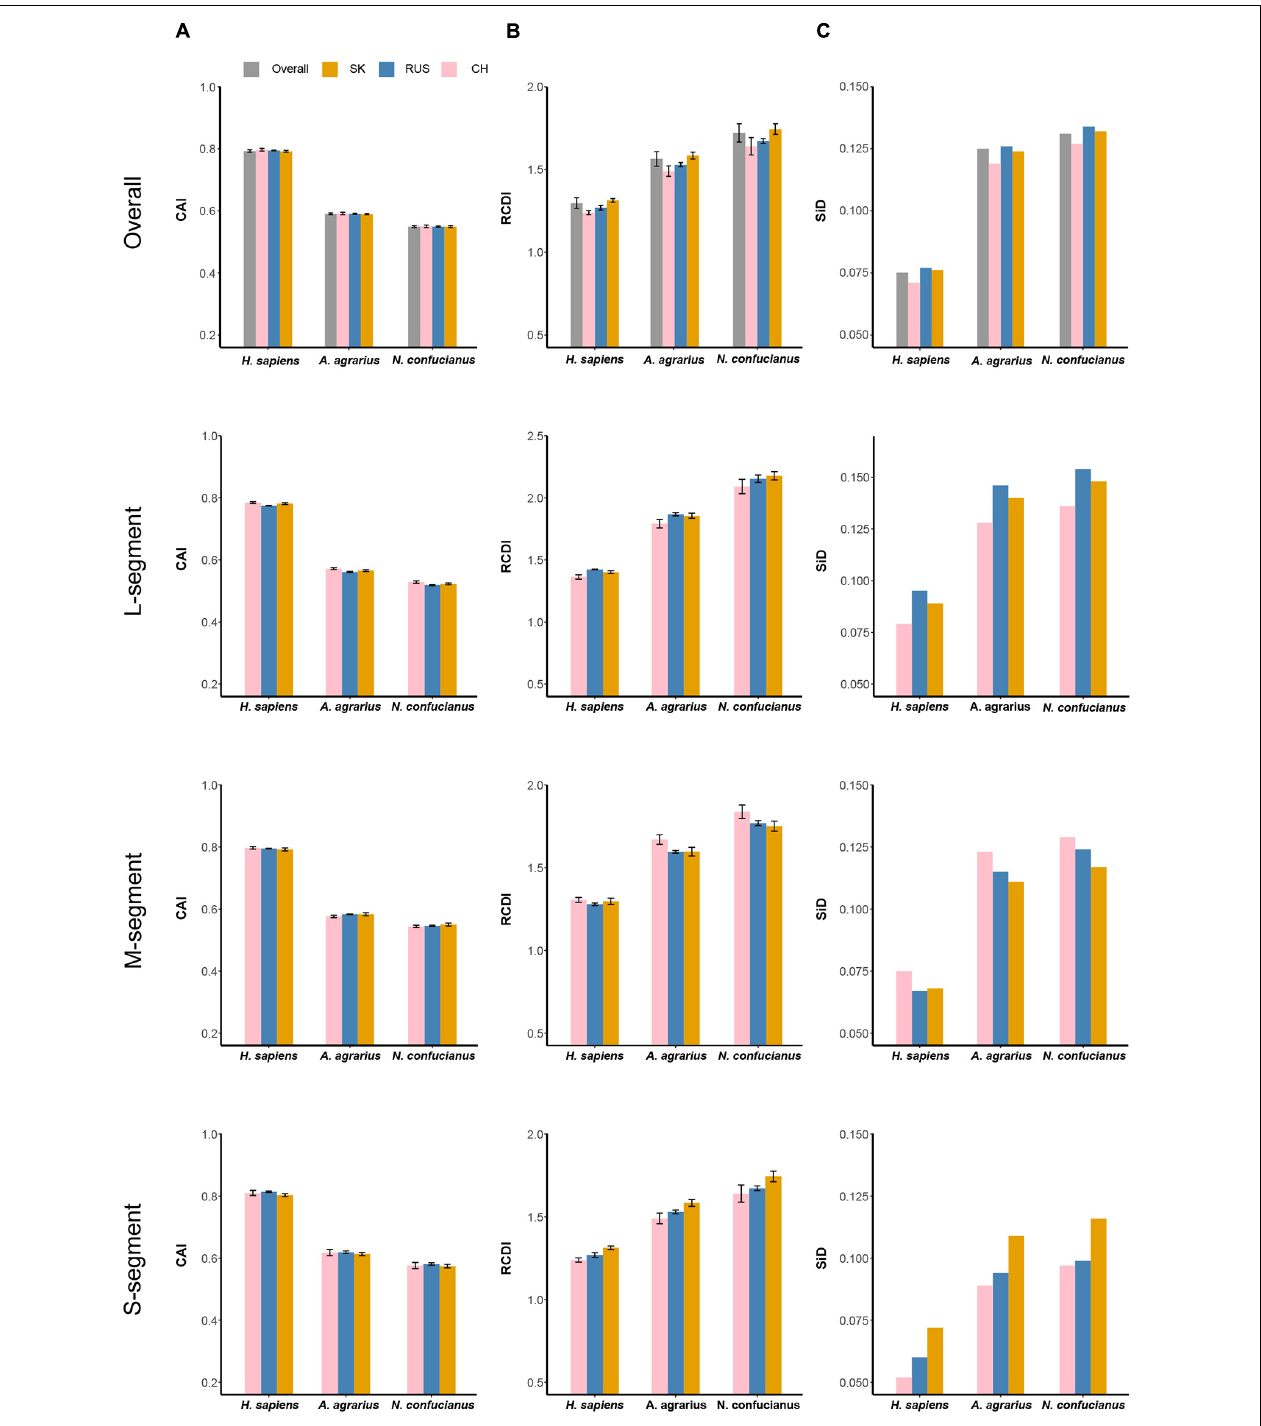
FIGURE 8 | Codon usage adaptation indices of HTNV to its host and natural reservoirs. (A) Codon adaptation index (CAI), (B) relative codon deoptimization index (RCDI), and (C) similarity index (SiD). Standard deviation was showed in (A) and (B)